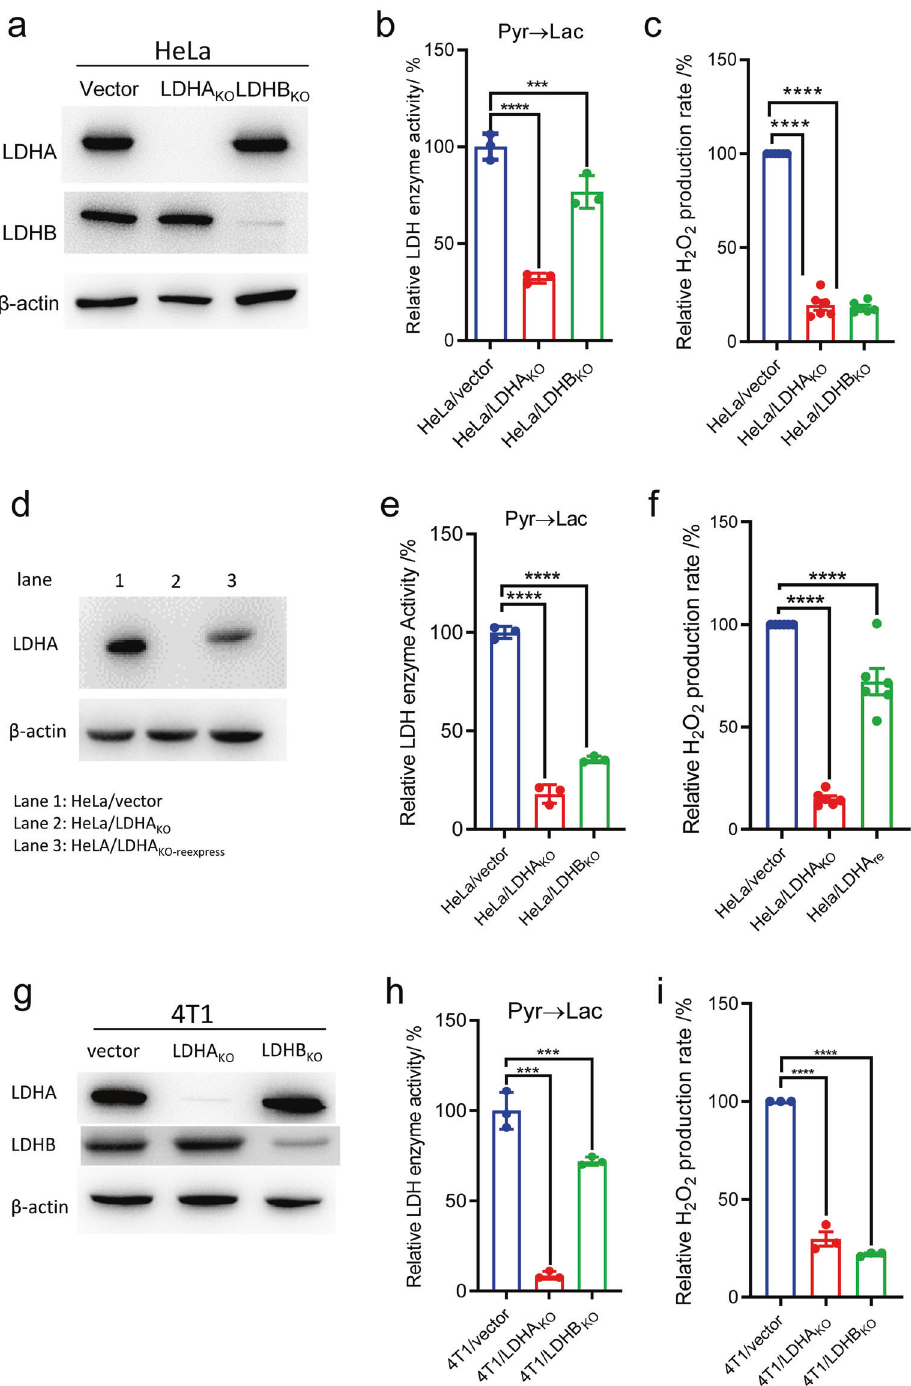
Fig. 2 The western blot, LDH enzyme activity and H 2 O 2 production rate in HeLa and 4T1 cells. a Western blot con fi rmation of LDH knockout in HeLa LDH knockout cell lines. b Speci fi c LDH enzyme activity assayed by converting pyruvate to lactate in HeLa LDH knockout cells. c Relative H 2 O 2 production rate in HeLa LDH knockout cells. d Western blot con fi rmation of LDH re-expression in HeLa LDH knockout cell lines. e Speci fi c LDH enzyme activity assayed by converting pyruvate to lactate in HeLa LDH knockout and re-expression cells. f Relative H 2 O 2 production rate in HeLa LDH knockout and re-expression cells. g Western blot con fi rmation of LDH knockout in 4T1 LDH knockout cell lines. h Speci fi c LDH enzyme activity assayed by converting pyruvate to lactate in 4T1 LDH knockout cells. i Relative H 2 O 2 production rate in 4T1 LDH knockout cells. Data were con fi rmed by at least three independent experiments. The experimental details are described in Materials and